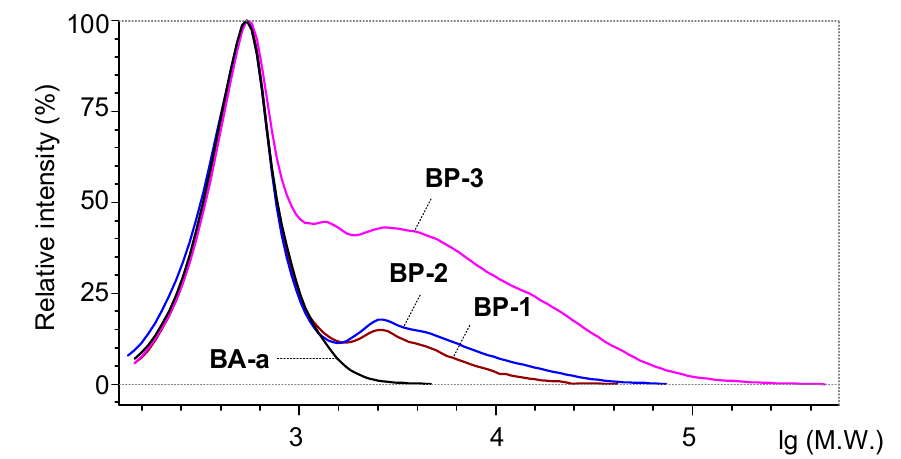
Figure 8. Molecular weight distribution and composition of BA-a benzoxazine and phosphazene- containing benzoxazines according to GPC.